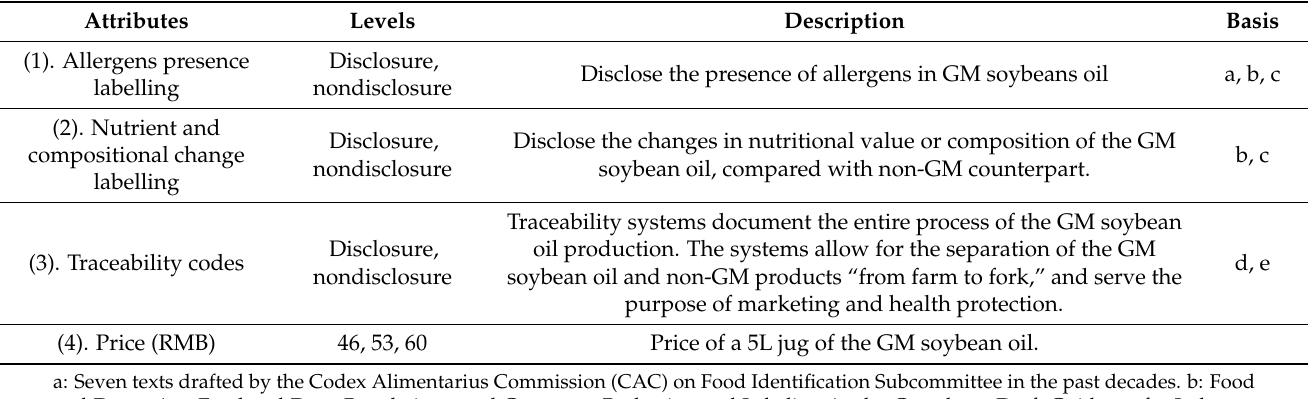
Table 1. Attributes and levels in the choice experiment.